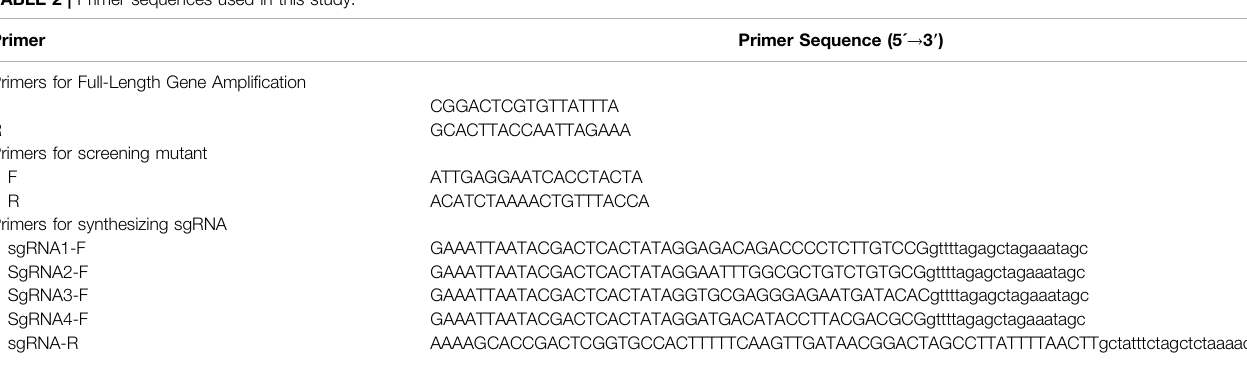
TABLE 2 | Primer sequences used in this study.